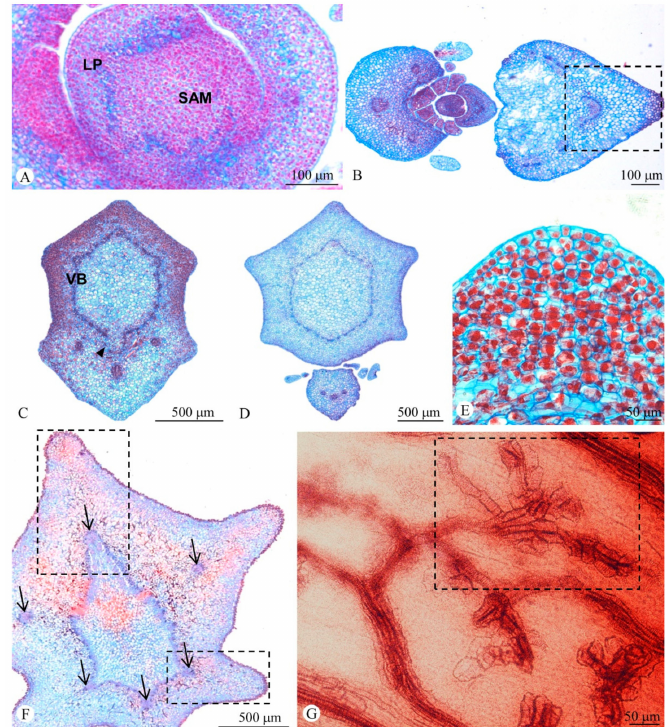
Figure 2. Ontogeny and vasculature of the shoot in Euphorbia attastoma ( A , C , D , F ) and E. tetrangularis ( B , E , G ). ( A ) Origin of the leaf primordium (LP) in the flank of the shoot apical meristem (SAM). ( B ) Leaves from distinct nodes in different developmental stages. Note the parenchymatic expansion of the midrib of the leaf (dashed square). ( C ) Nodal region showing three leaf traces associated with their respective ribs and the leaf gap (arrowhead). ( D ) Reduced leaf with three bundles and the ribbed stem. ( E ) Detail of the anticlinal and periclinal division of the ground meristem cells during rib development. ( F ) Divergence of leaf traces from the eustele, evidencing their relationship with the stem ribs (arrows). Note the profuse multiplication of parenchyma in front of each trace, forming the ribs (dashed squares). ( G ) Leaf terminal venation with areoles composed of tracheids (dashed square). VB = vascular